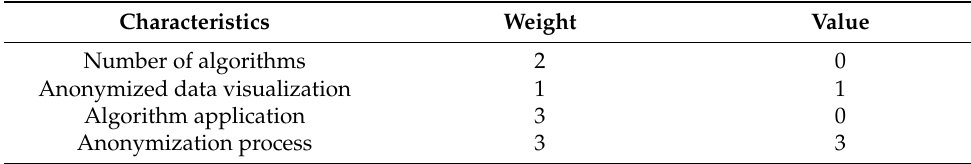
Table 3. Functionality